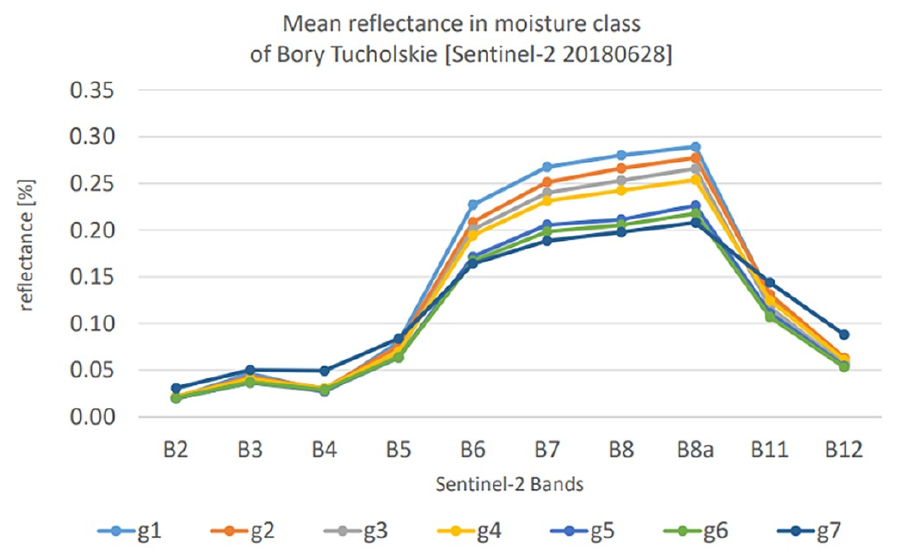
Figure 3. Spectra of seven FHMI in Bory Tucholskie National Park based on the Sentinel-2 image recorded on 28 June 2018 .